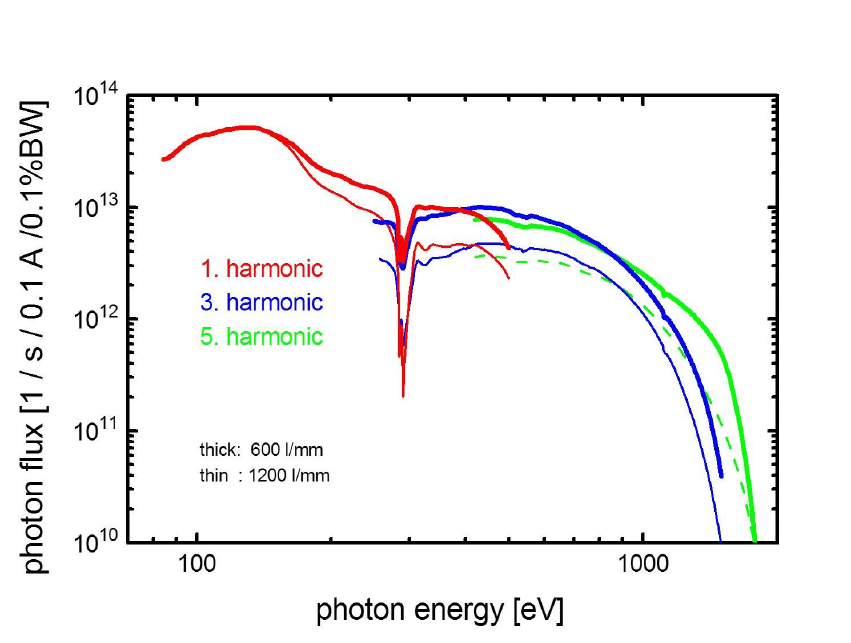
Figure 2: Photon flux at beamline U49/2 PGM1.